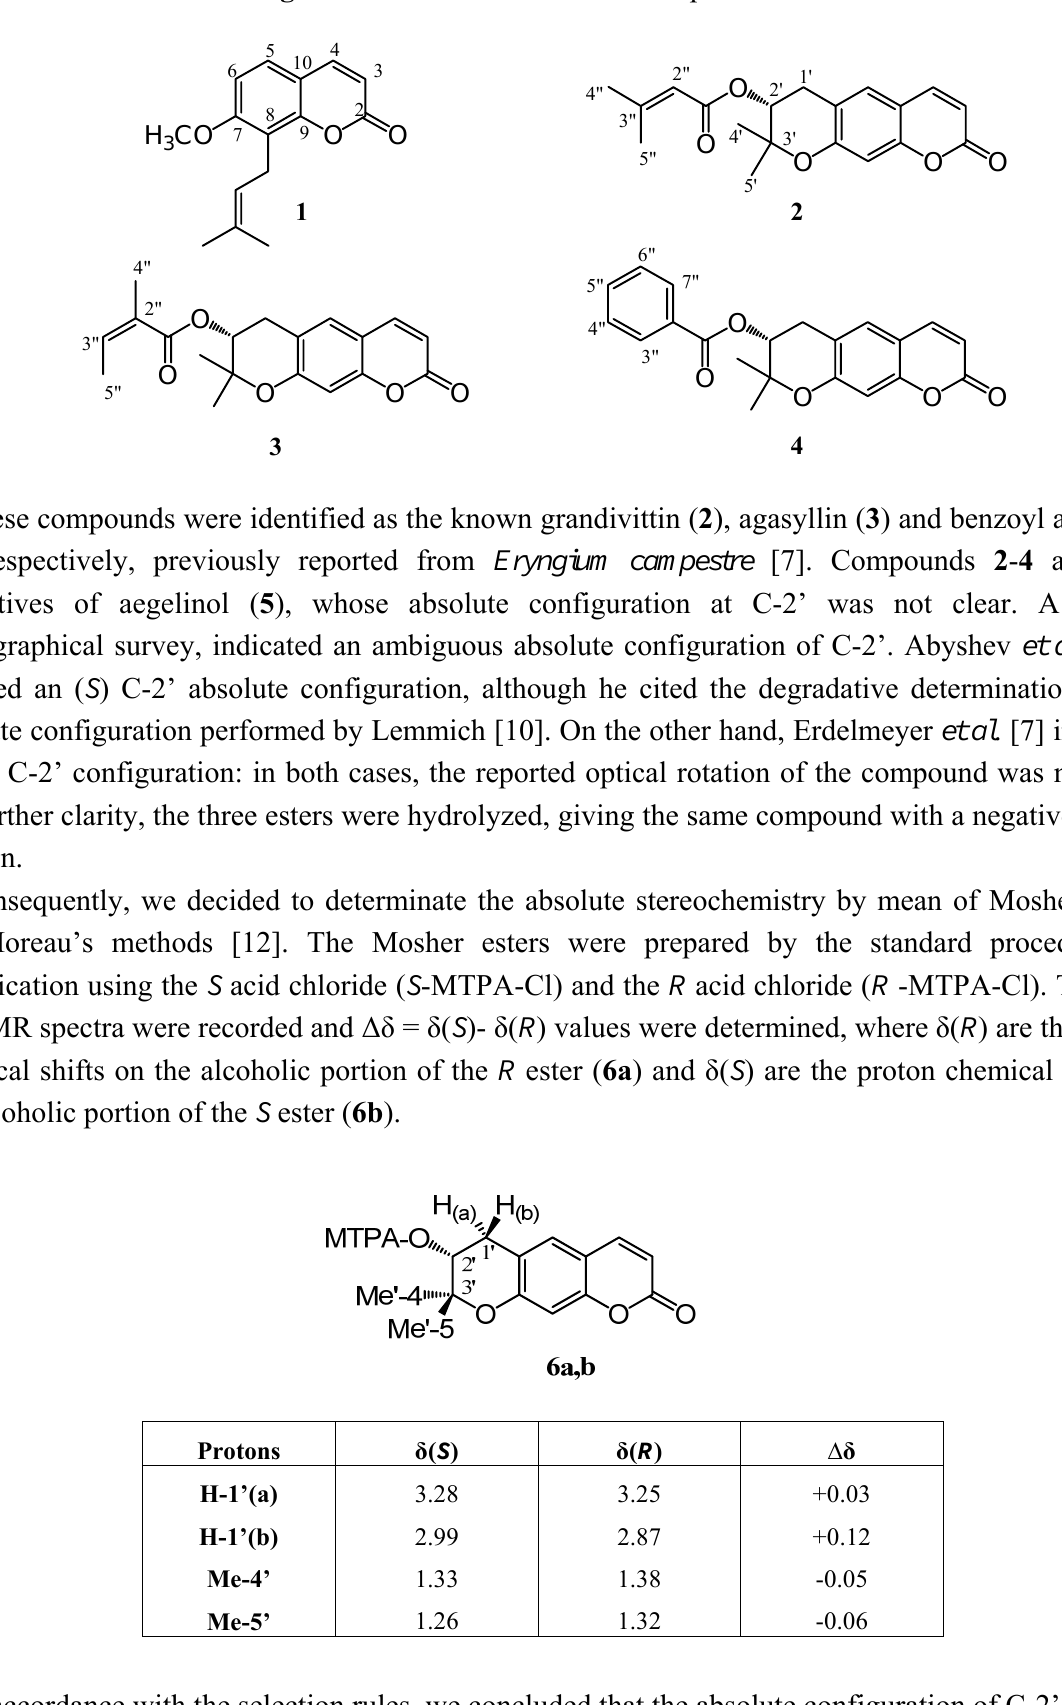
Figure 1 . Structures of isolated compounds 1 - 4